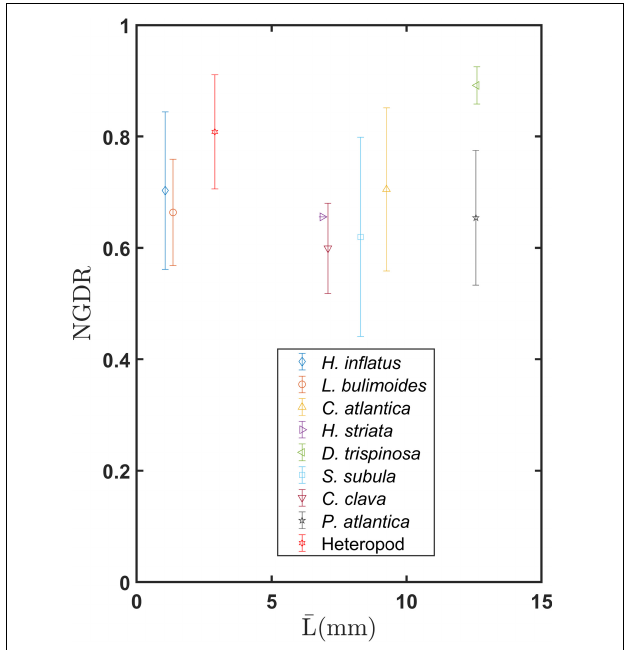
FIGURE 9 | Mean and standard deviation of NGDR measured over five body lengths for various marine snail species as a function of mean body length ¯ L .